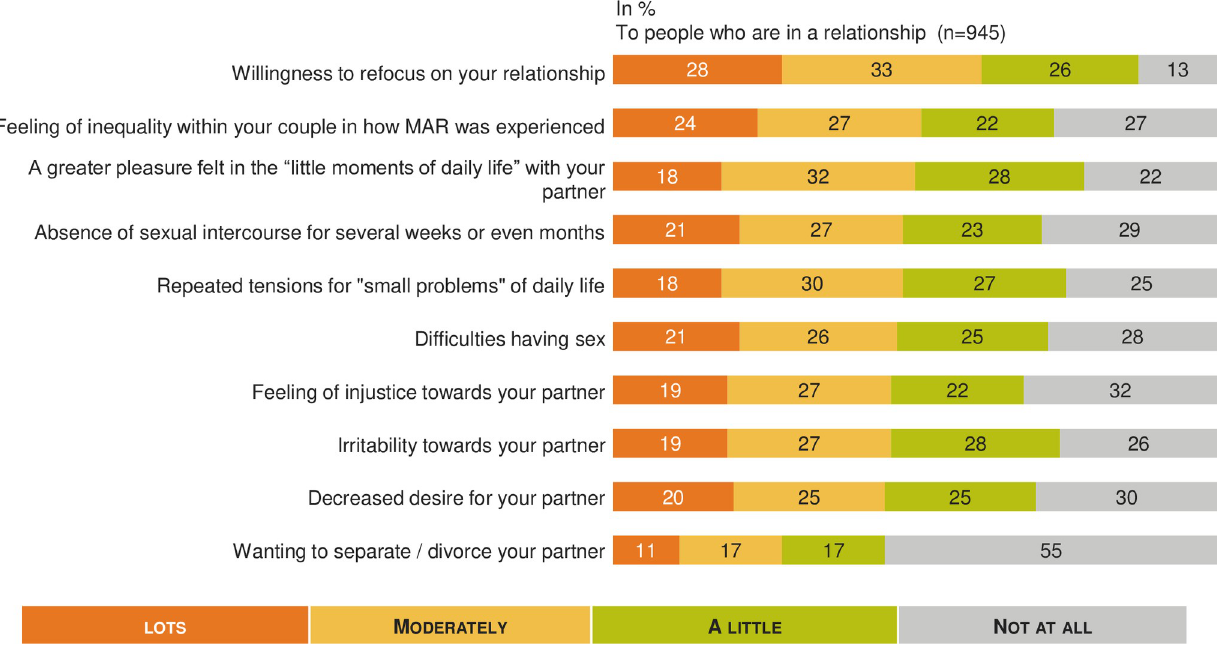
Fig 4. MAR burden on affective life: A French national survey. Percentage of answers to the question “Regarding your affective life would you say that you felt each of the following a lot, moderately, a little, not at all?” (n = 945).